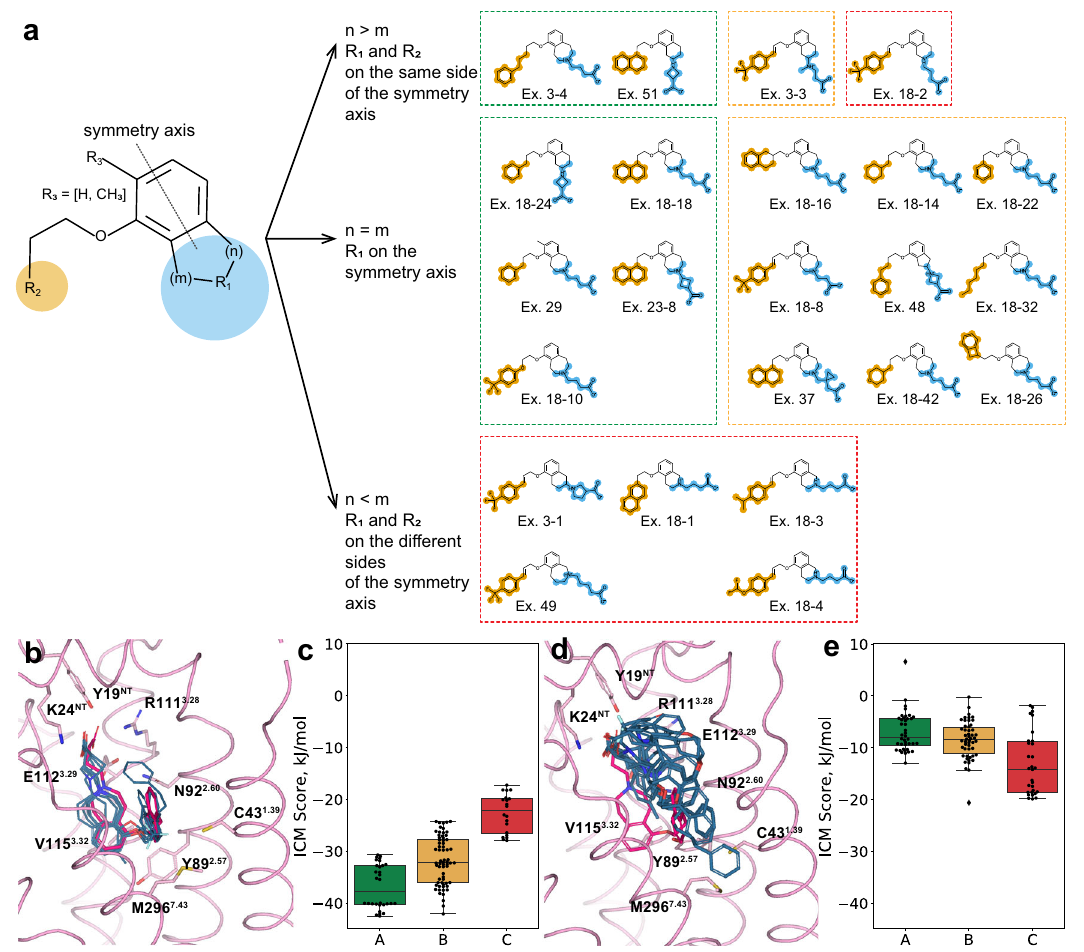
Fig. 4 | Ligand docking simulations and substituent decomposition analysisof ONO-5430608 ligand series. a The main scaffold and substituents. The double- ring system symmetry axis is shown as a dotted line. Rows represent different substituent ’ s placements around the double-ring system symmetry axis: R 1 and R 2 are on the same side (top row), R 1 is on the axis (middle row), R 1 and R 2 are on the different sides (bottom row). Ligand groups are outlined with respect to their af fi nities: group ‘ A ’ (1nM < IC 50 < 100 nM, 7 ligands) in green, group ‘ B ’ (100nM < IC 50 < 1 μ M, 10 ligands) in yellow, and group ‘ C ’ (1 μ M < IC50 < 3 μ M, 6 ligands)